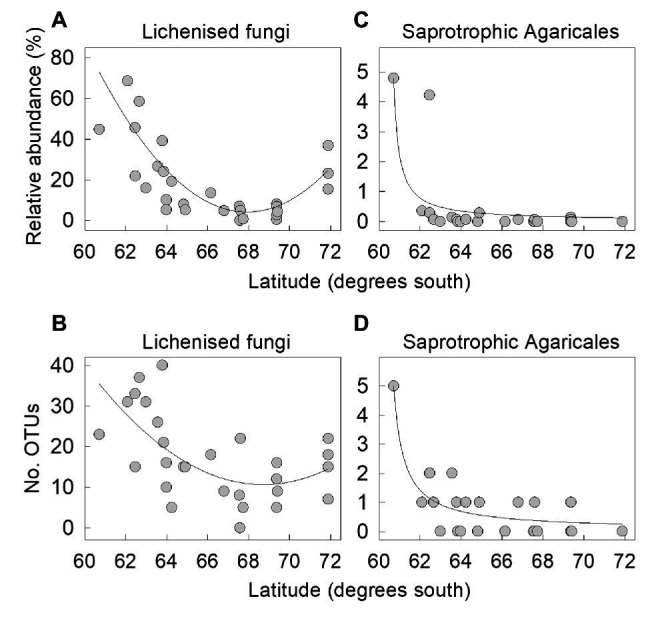
The relative abundances of (A,C) lichenised fungi and saprotrophic Agaricales as functions of latitude and the number of OTUs of (B,D) lichenised fungi and saprotrophic Agaricales as functions of latitude. Lines show significant first order polynomial (A,B) and hyperbolic (C,D) fits.